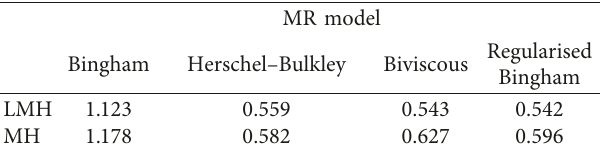
Table 3: Root mean square (rms) value of the sprung mass accel- eration for simulations with nonhysteretic models (units in m/s 2 ).